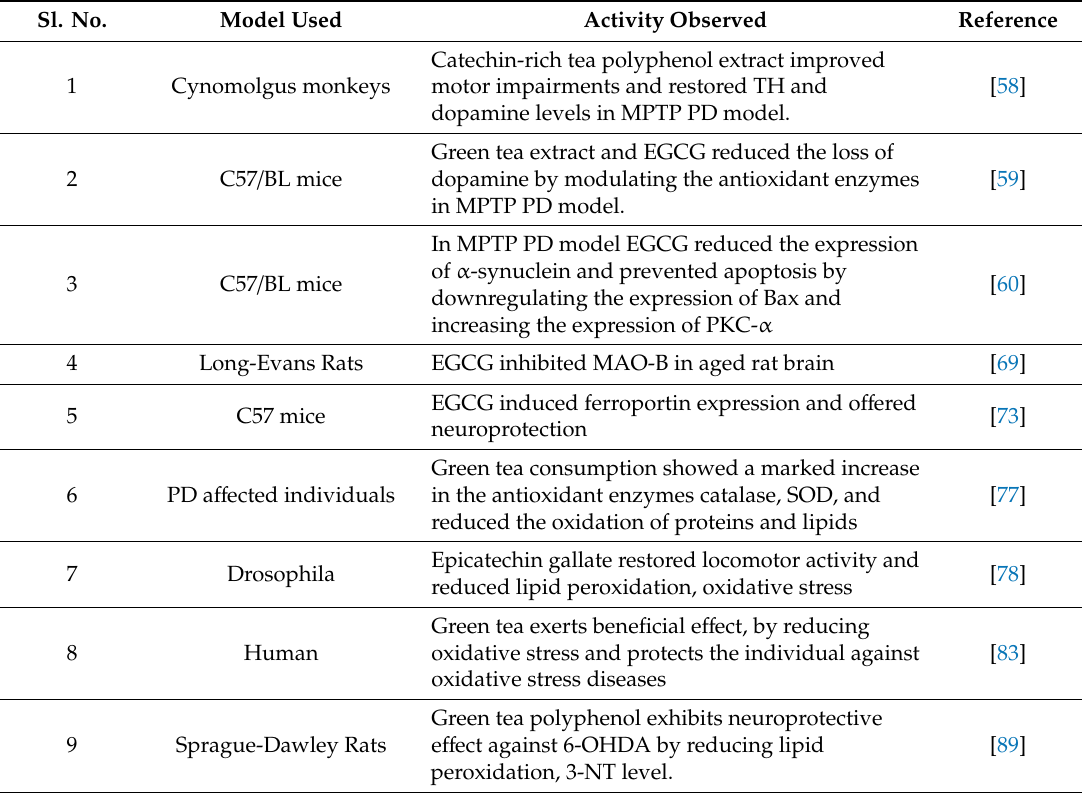
Table 2. Green tea can exhibit anti-Parkinson’s e ff ect— in vivo evidence. Sl.